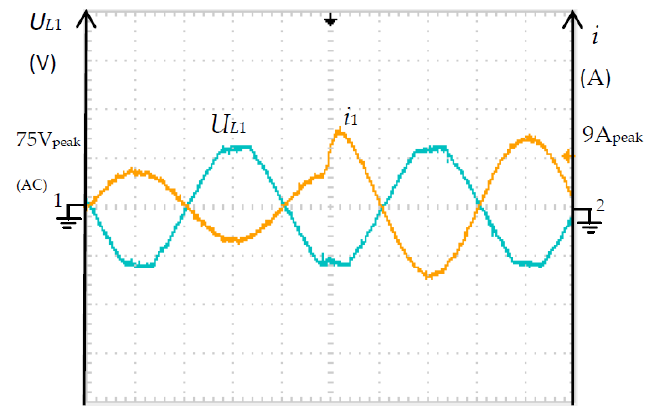
Figure 9. Experimental results of AC currents, i 1 , i 2 , and i 3 , of AC microgrid when there is a varia- tion of AC power in step. Vertical: 6 A/div. Horizontal: 5 ms/div.